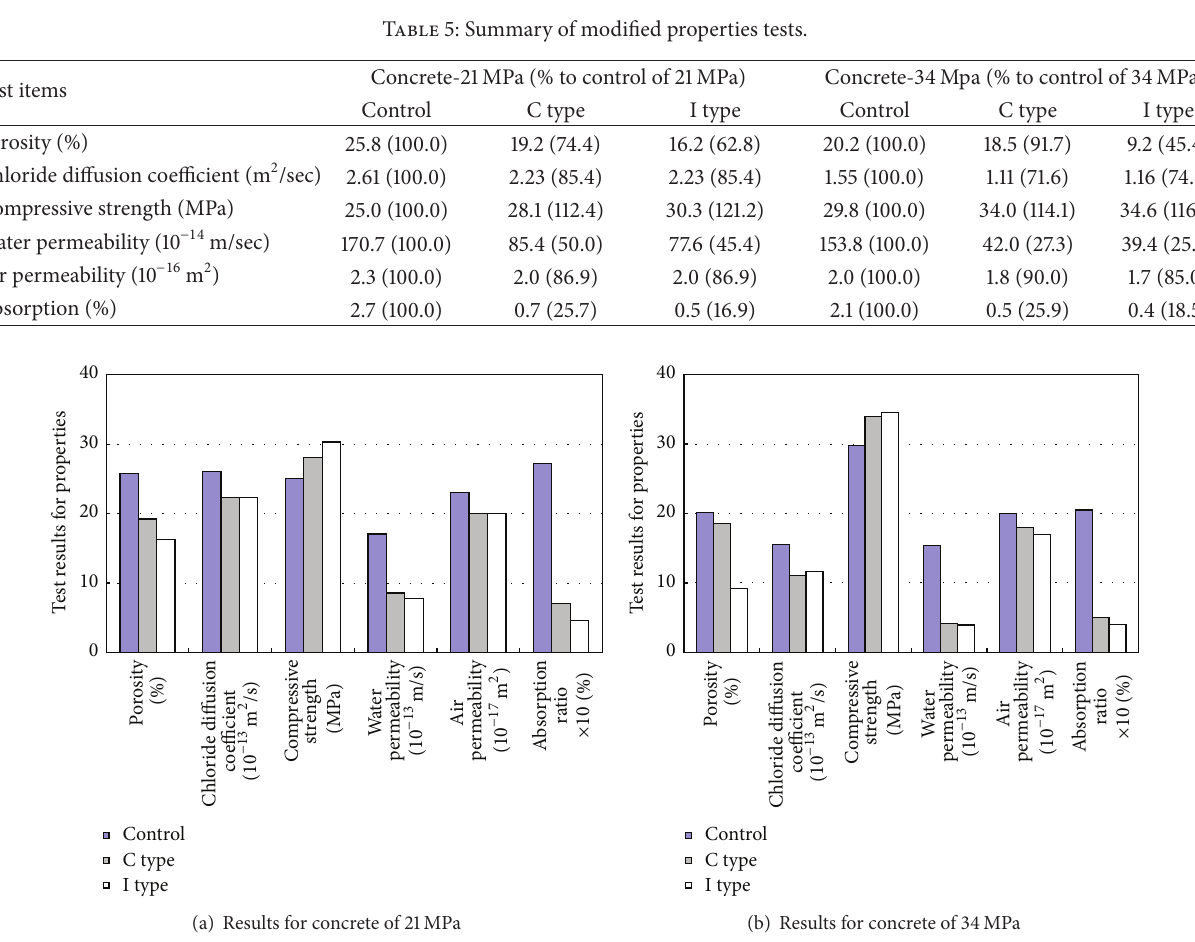
Figure 4: Results for modified properties